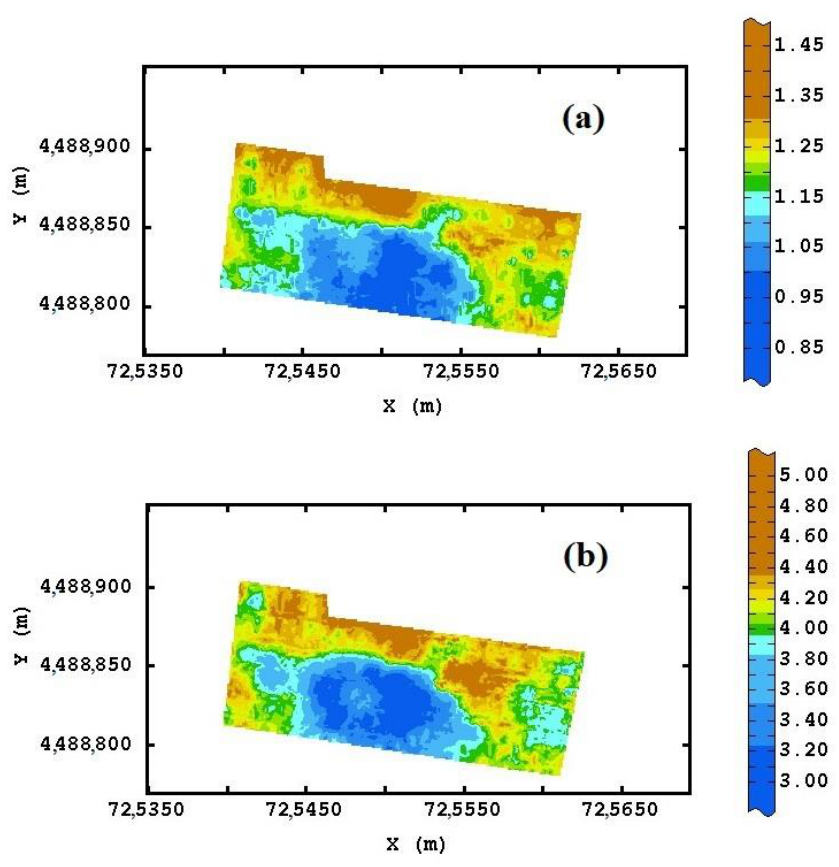
Figure 11. The R1 ( a ) and R2 ( b ) ratio maps. Colour scale uses isofrequency classes.